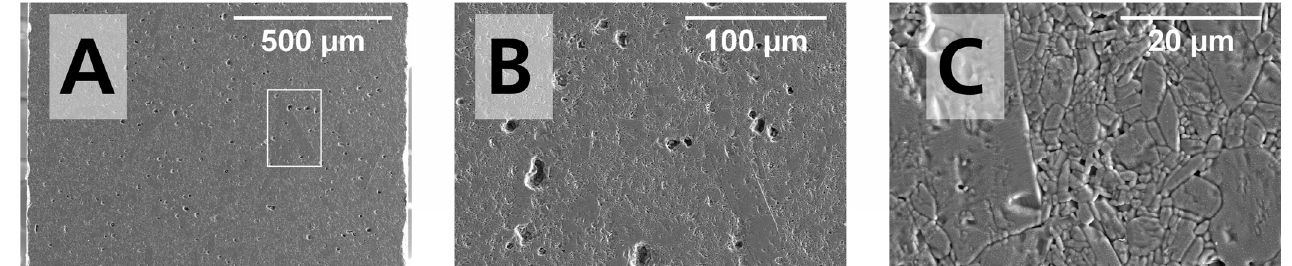
Figure 2. SEM images of the pristine sample’s polished fracture surface with ( A ) no ( B ) medium and ( C ) large magnifications. The white box highlights a grain with a length of 230 µm.